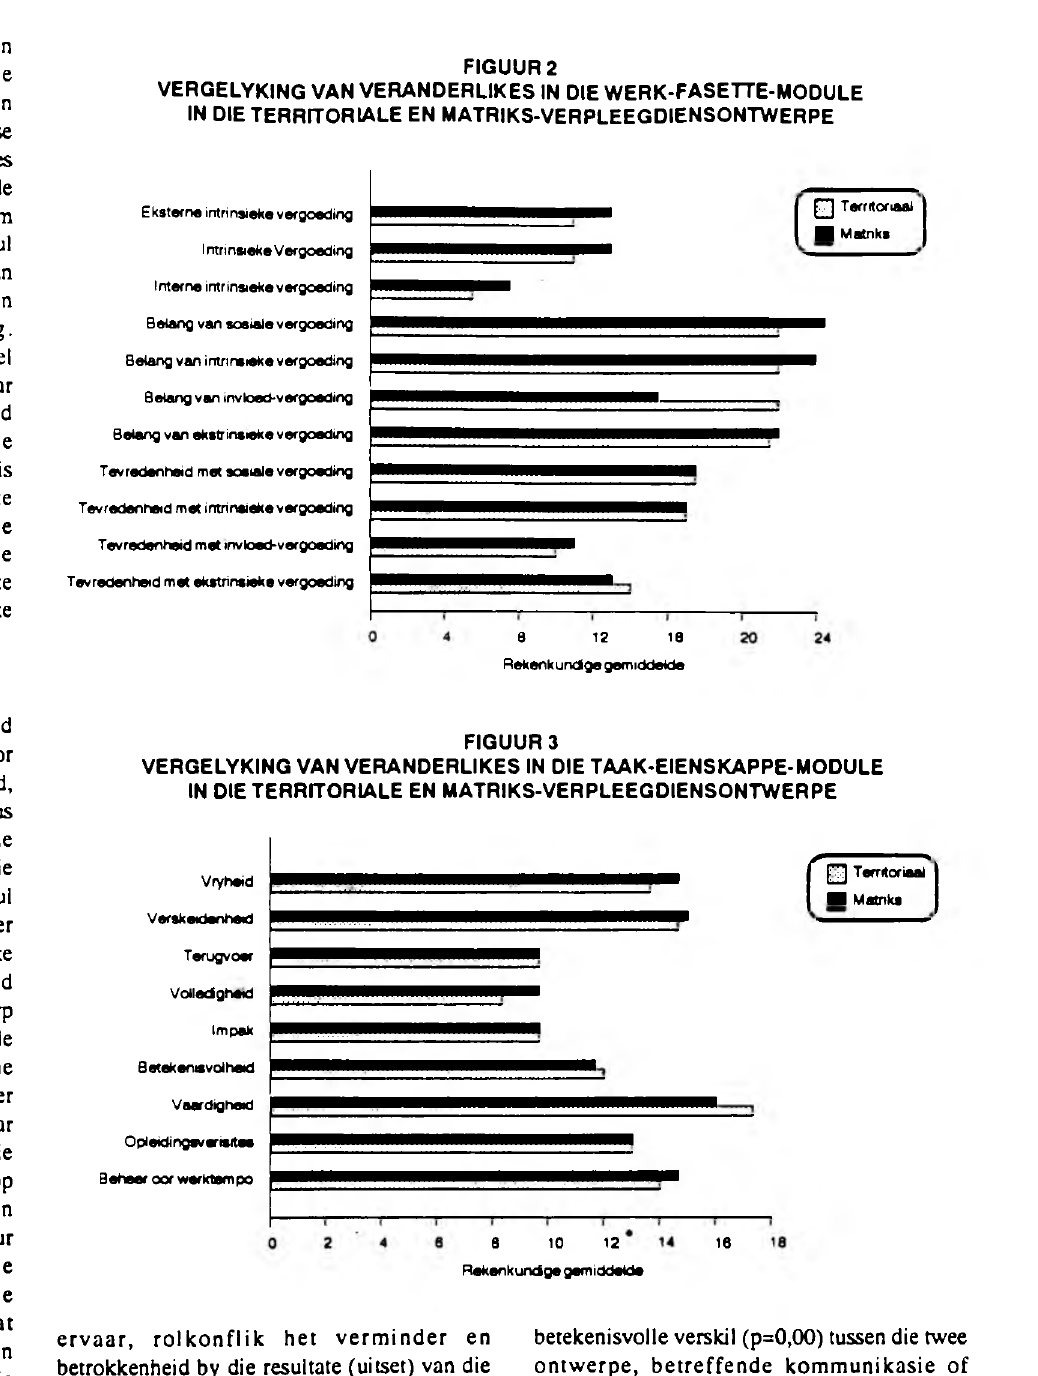
FIGUUR 3 VERGELYKING VAN VERANDERLIKES IN DIE